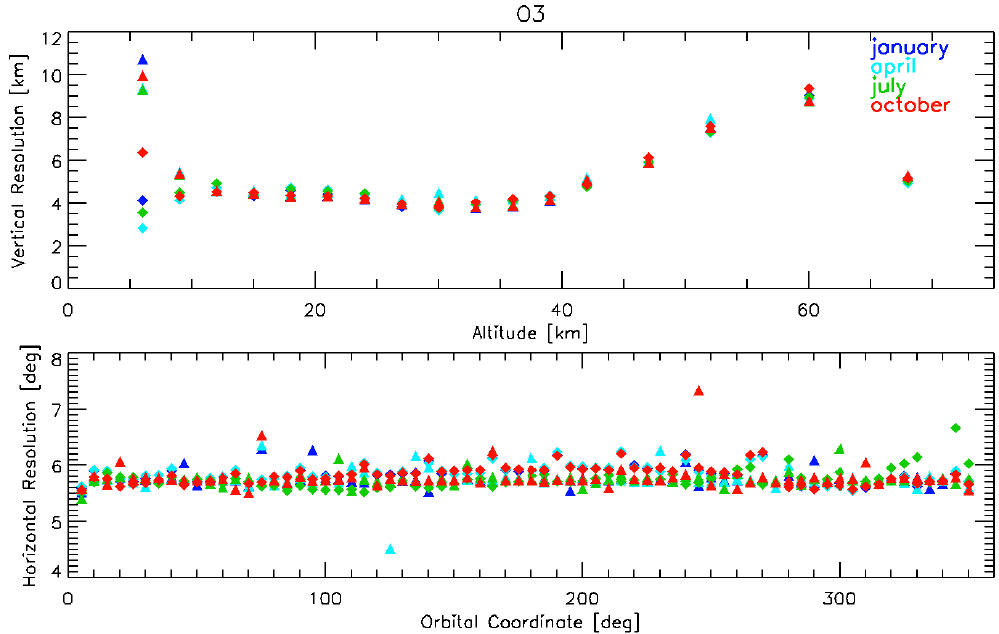
Fig. 8. Comparison of ozone vertical (top panel) and horizontal (bottom panel) averaged resolutions computed for the FR (diamonds) and OR (triagles) missions. The colours identify the season as reported in the